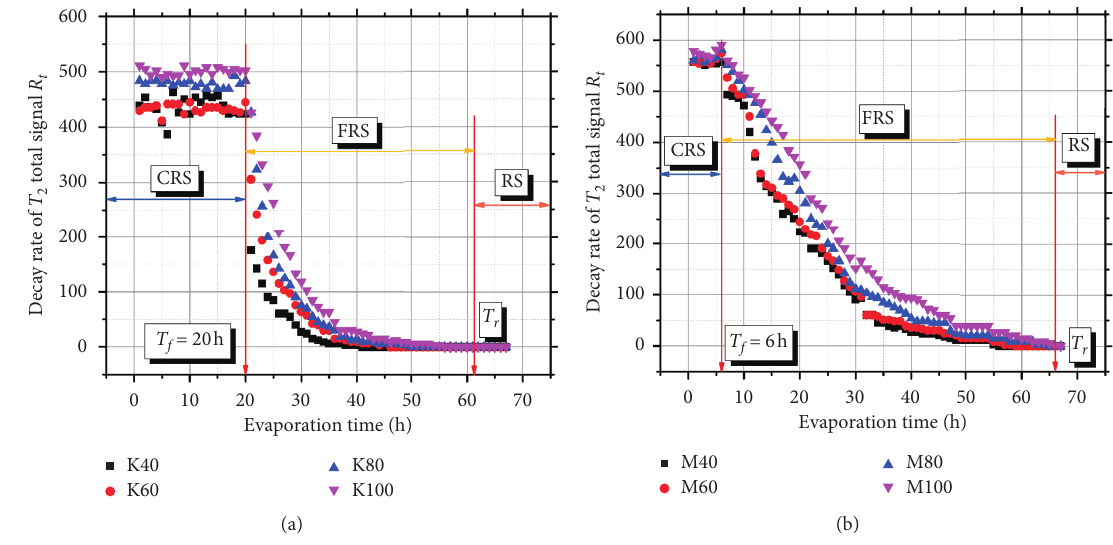
Figure 6: The decay rate of the T 2 total signal versus evaporation time: (a) K-group and (b) M-group.